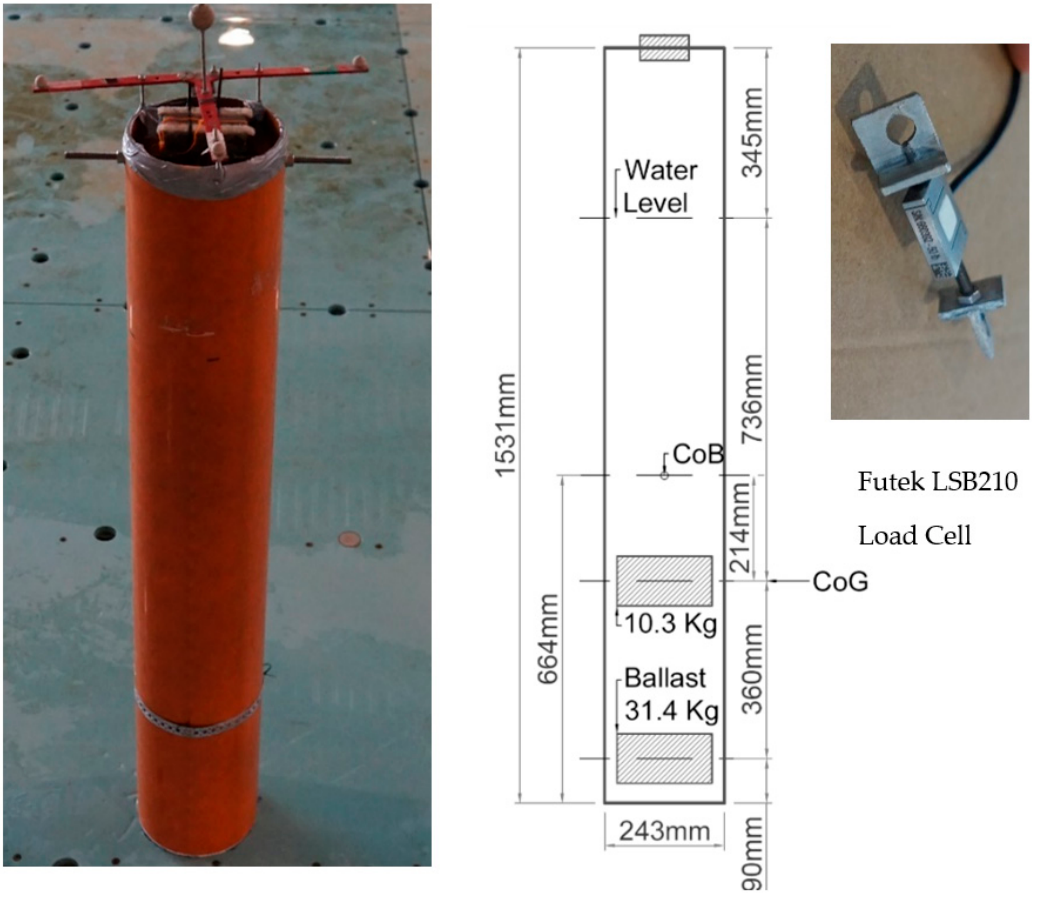
Figure 1. Spar buoy platform model photograph and drawing.